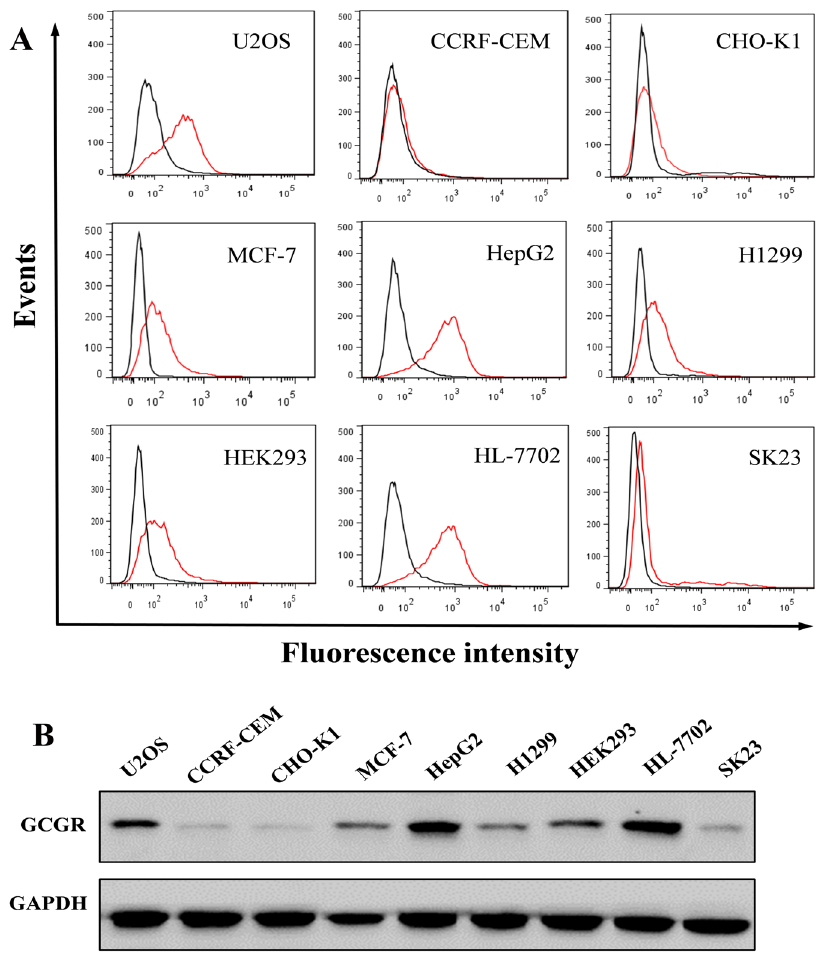
Figure 6. Analysis of binding specificity of aptamer GR-3 to other cell lines. ( A ) FAM-labeled GR-3 (250 nM, red line) was incubated with cell lines of different origins and analyzed by flow cytometry. The unselected initial library (250 nM, black line) was used as control. ( B ) The expression of GCGR protein in different cell lines was analyzed by Western blot. GAPDH was used as an internal control. Original blots are presented in Supplementary Figure